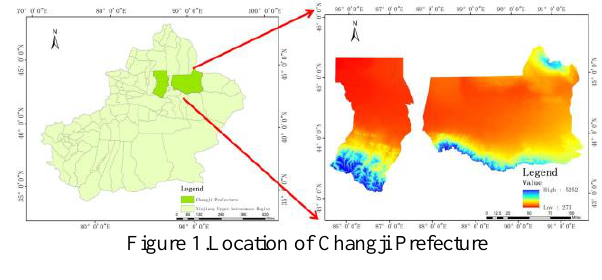
Figure 2.Assessment index system of grassland health in Changji